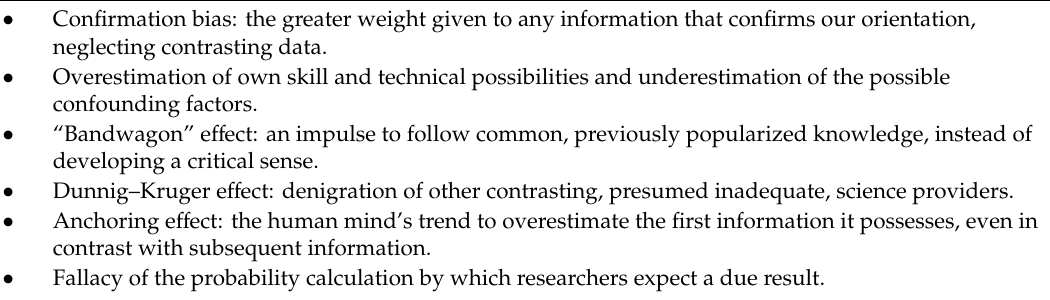
Table 3. The most common cognitive